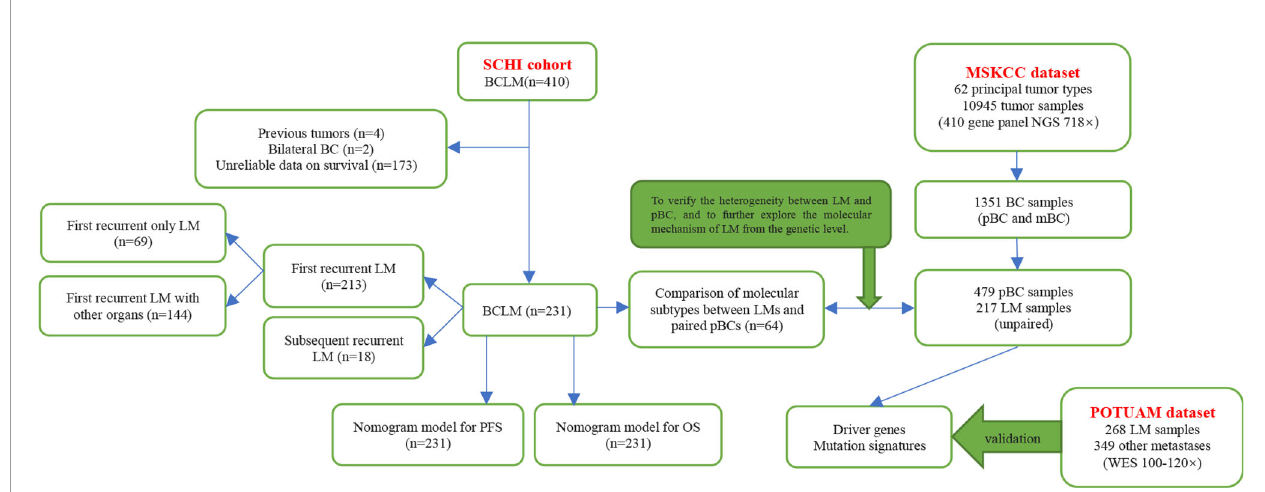
FIGURE 1 | Article structure frame diagram. SCHI, Shandong Cancer Hospital and Institute; MSKCC, Memorial Sloan Kettering Cancer Center; POTUAM, Predictive Oncology team of the University of Aix-Marseille; NGS, next-generation sequencing; WES, whole-exome